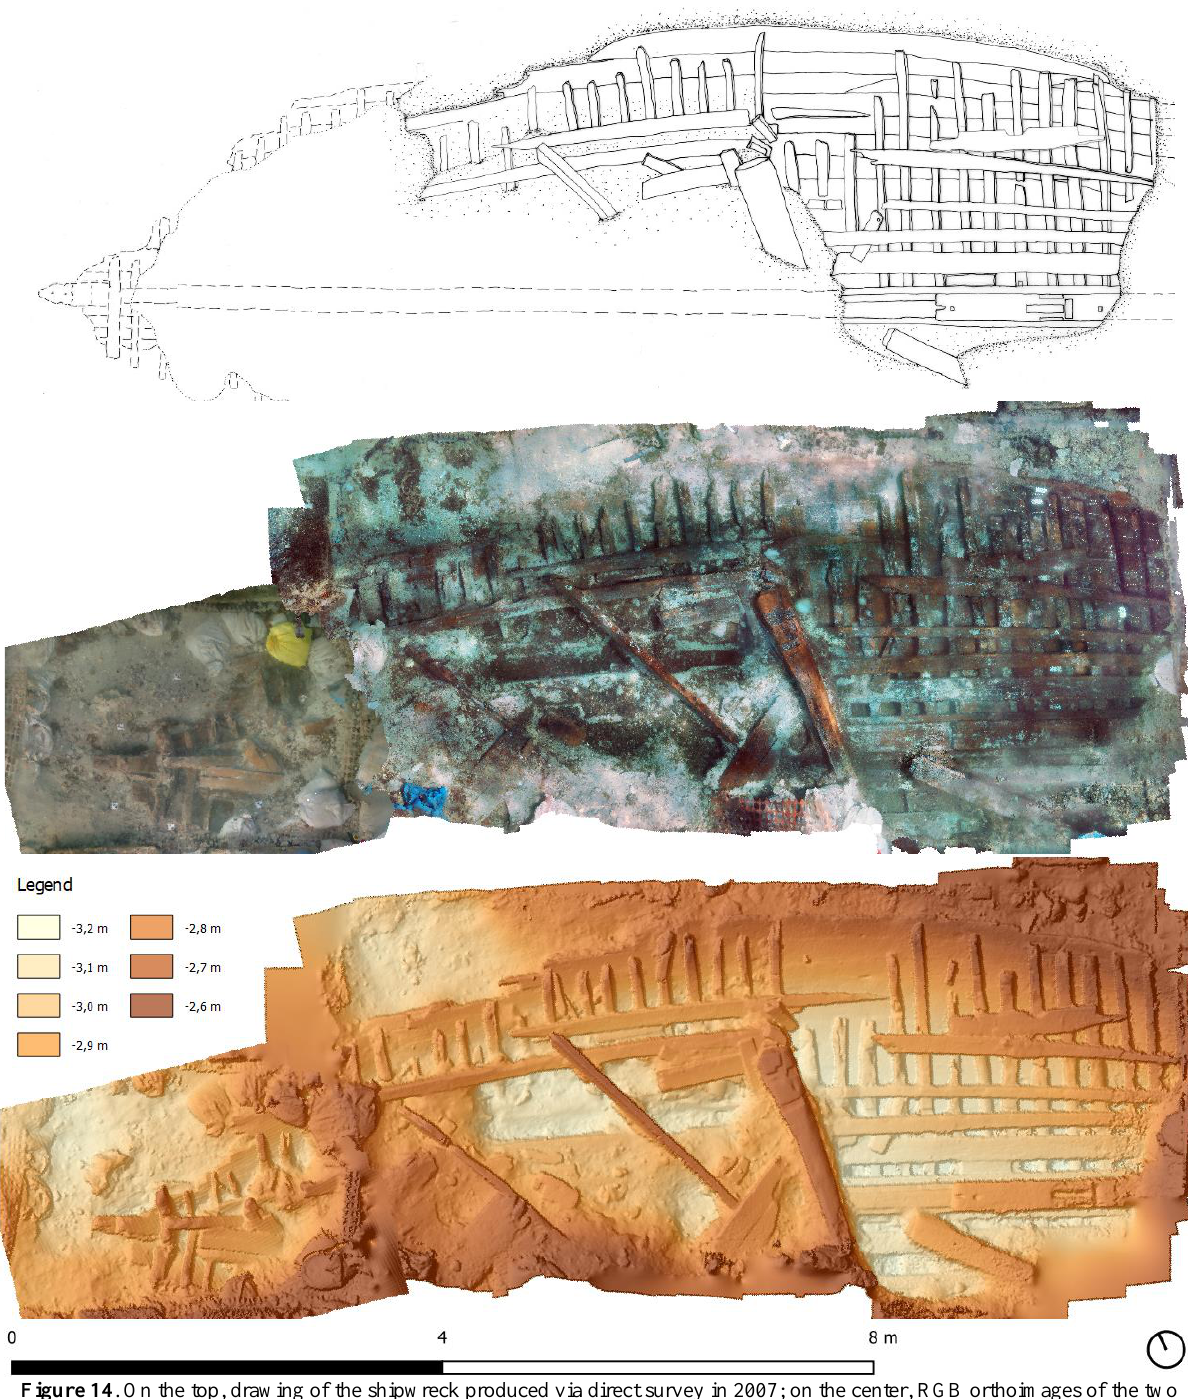
Figure 14 . On the top, drawing of the shipwreck produced via direct survey in 2007; on the center, RGB orthoimages of the two parts of the wreck surveyed in 2007 (right) and 2020 (left); on the bottom, DEMs of the same orthoimages of the two